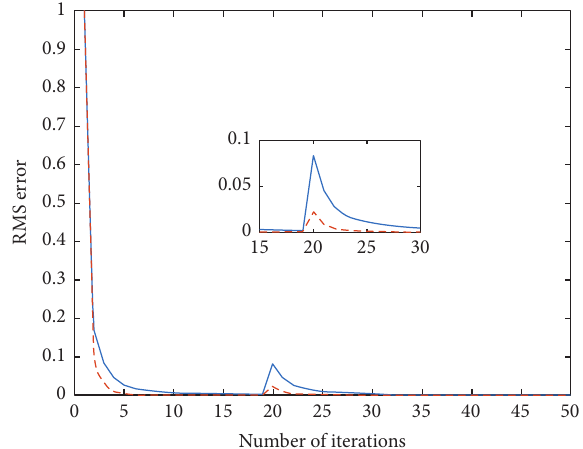
Figure 2: RMS error with and without uncertainty.